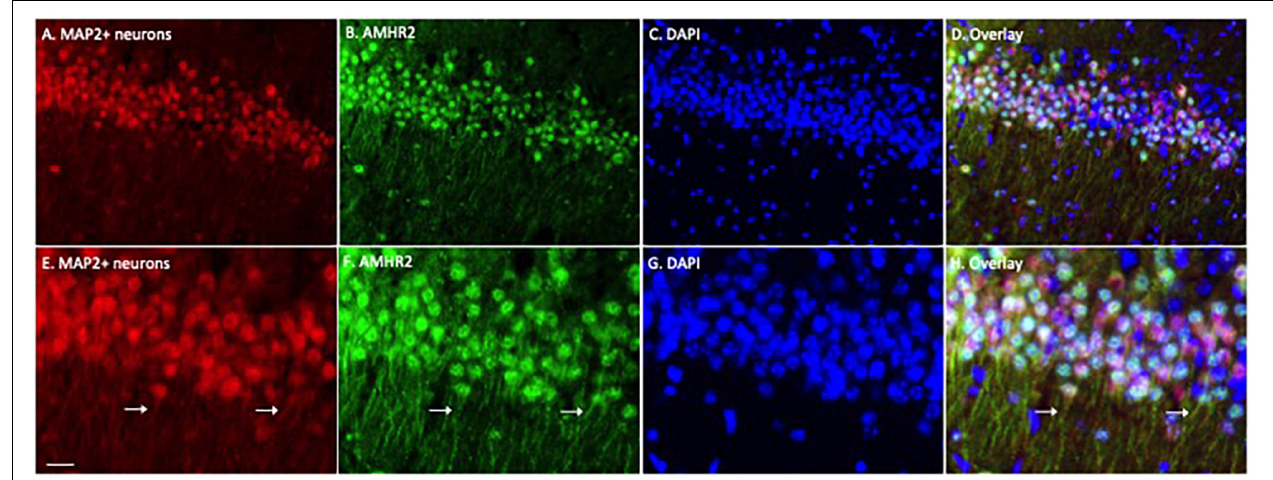
FIGURE 1 | Anti-Müllerian hormone receptor 2 is expressed in the CA1 pyramidal neurons of mouse hippocampus. Representative coronal section was fluorescent-labeled for microtubule-associated protein 2 (MAP2; red; A,E ), AMHR2 (green; B,F ), and DAPI (nuclear staining; blue; C,G ). MAP2 and AMHR2 proteins are co-localized in neurons (D,H) . Arrows point to the representative dendrites of CA1 neurons. Scale bar = 40 µ m in panel (A–D) and 10 µ m in panel (E–H) (high magnification images).